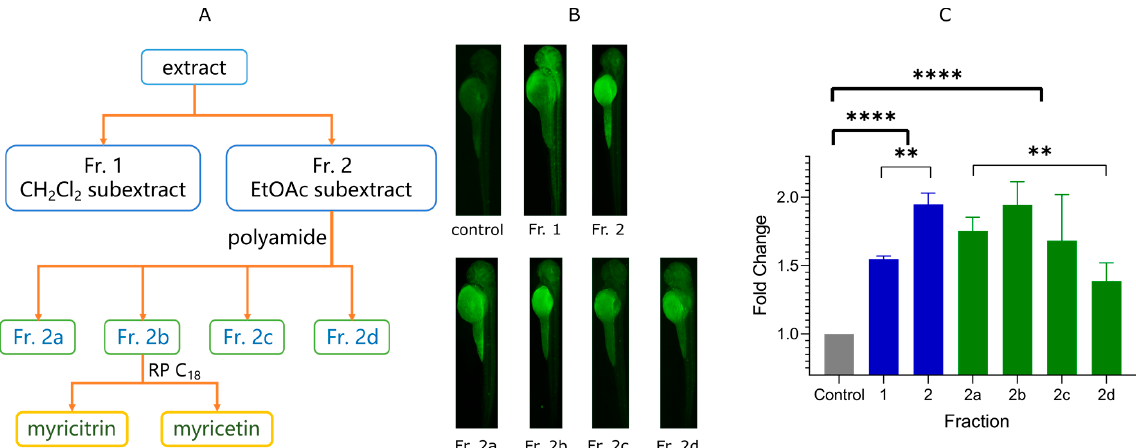
Figure 1. Bio-guided separation of the active components from Acer truncatum leaves. ( A ) Flow chart of bio-guided separation. ( B ) Fluorescent microscopy images after treatment of separated fractions. ( C ) Fold change of 2-NBDG fluorescence measured by ImageJ (** p < 0.01; **** p < 0.0001). The fold changes were calculated from the mean of the blank control. Green and blue are two different batches. The higher fold change indicates the better promotion of glucose uptake.